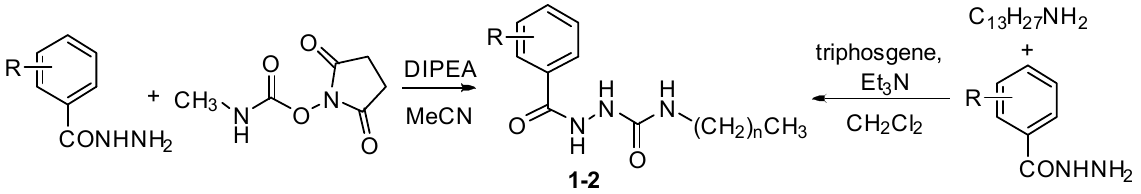
Table 1. Comparison of yields of different synthetic methods.